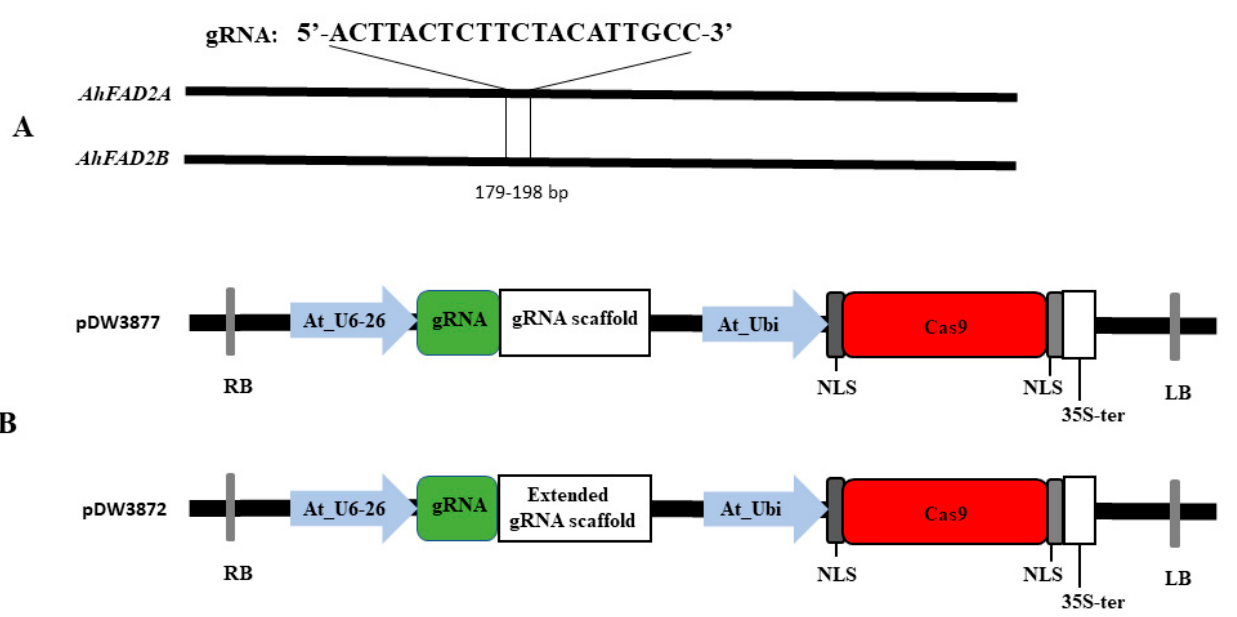
Figure 1. Schematic representation of the constructed vectors. ( A ) The target site and sequence of the designed gRNA in the AhFAD2A and AhFAD2B genes. ( B ) Representation of the CRISPR/Cas9 binary vector’s structures. The gRNA cassette was driven by the Arabidopsis U6-26 promoter, while the Cas9 was controlled by the Arabidopsis ubiquitin promoter for both constructs. In the pDW3877, the gRNA cassette was terminated with the regular scaffold, while in the pDW3872, the gRNA cassette was terminated with the extended gRNA terminator.